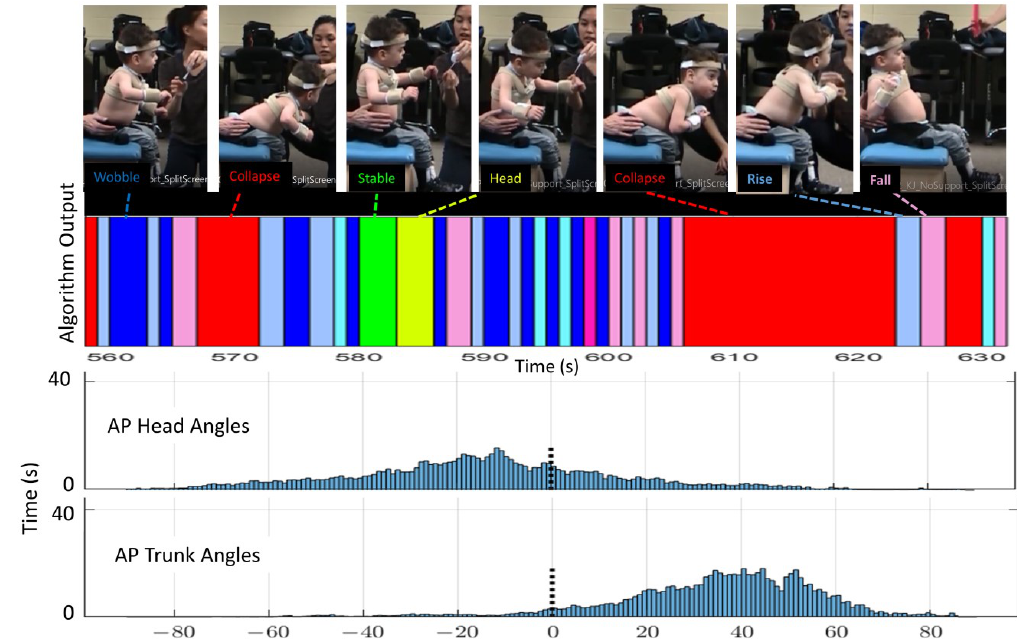
Figure 6. Example of algorithm output (colored bar, 70 s duration), AP histograms (bottom, full 12-min trial), and AP images from video for one child (02KJ) during the no support condition. The histogram is qualitatively most consistent with Wobble and Rise/Fall behaviors. The child’s head is more vertically aligned while his trunk is consistently leaning forward.